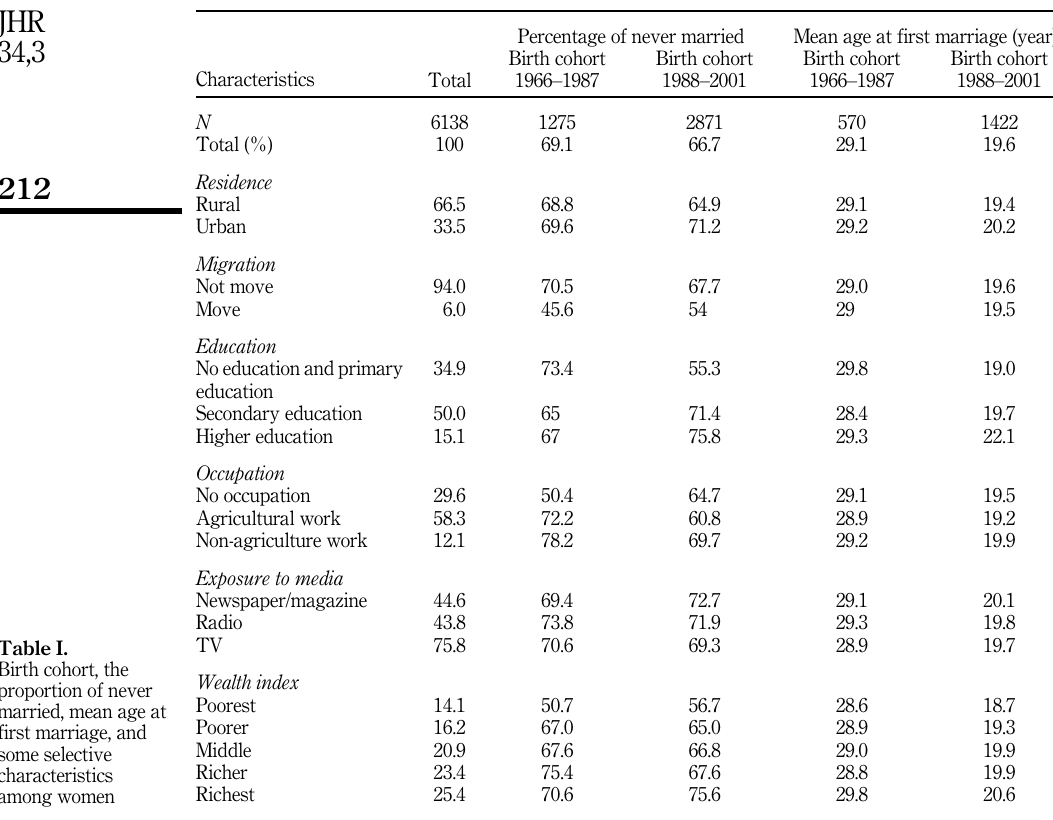
Table I. Birth cohort, the proportion of never married, mean age at first marriage, and some selective characteristics among